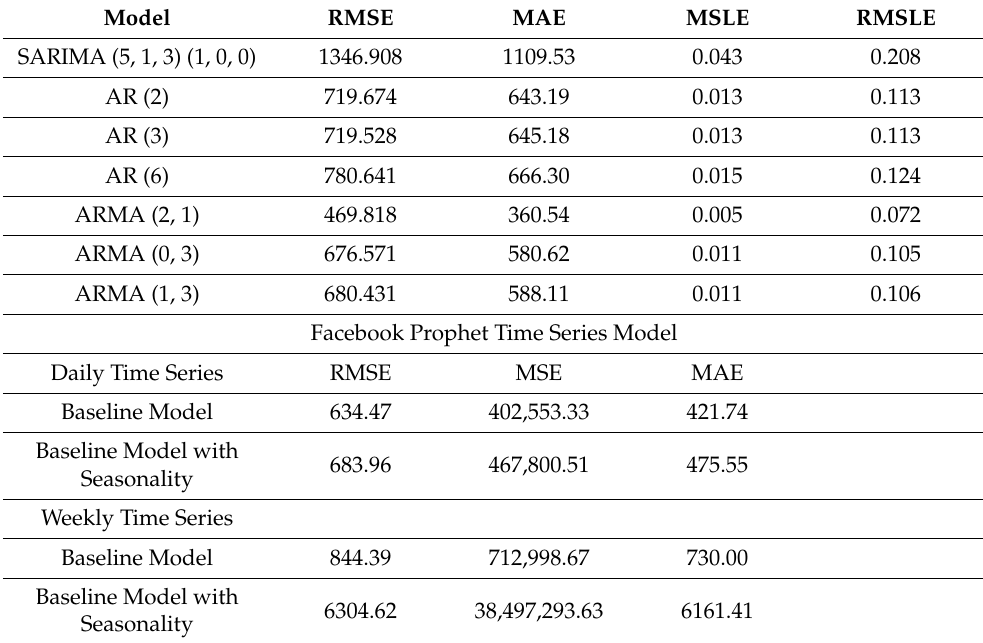
Table 3. Prediction performance of the different models SARIMA vs. Prophet